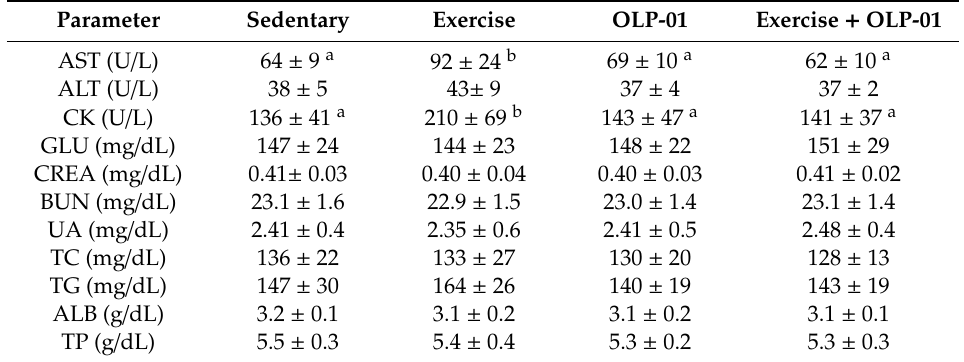
Table 3. E ff ects of exercise and probiotic intervention on clinical biochemical analysis at the end of the experiment.